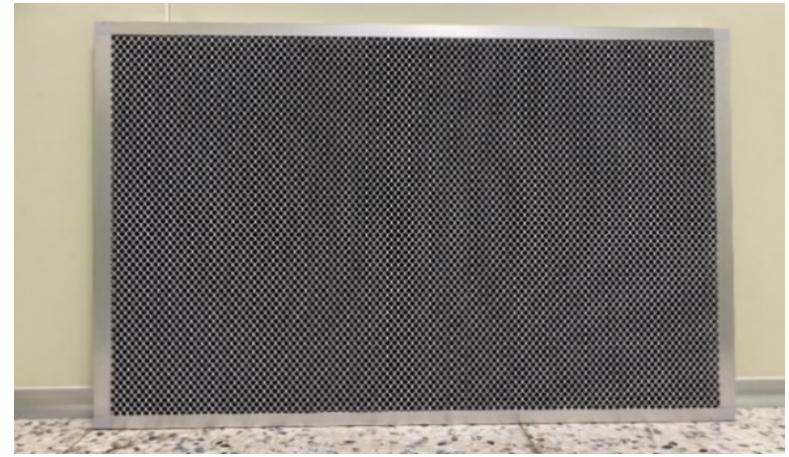
Figure 12. Experiment filter wind tunnel setup.